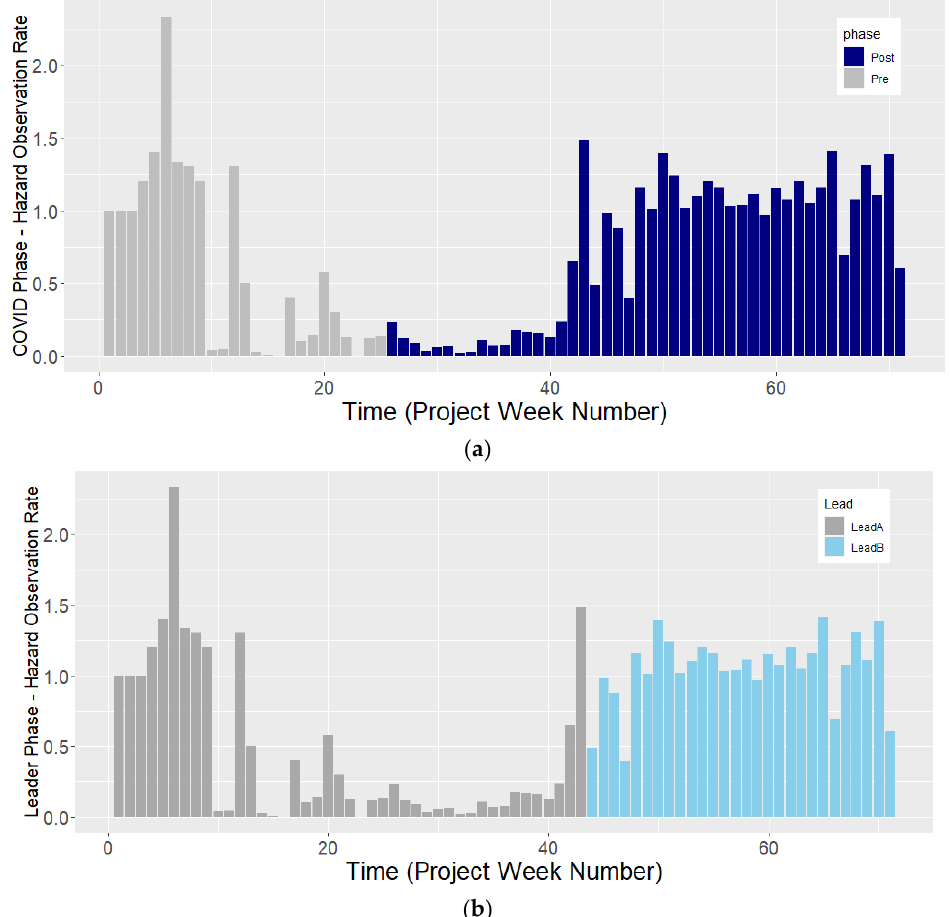
Figure 8. ( a ) Hazard observation rate by COVID Phase, ( b ) Hazard observation rate under different Project Leaders.